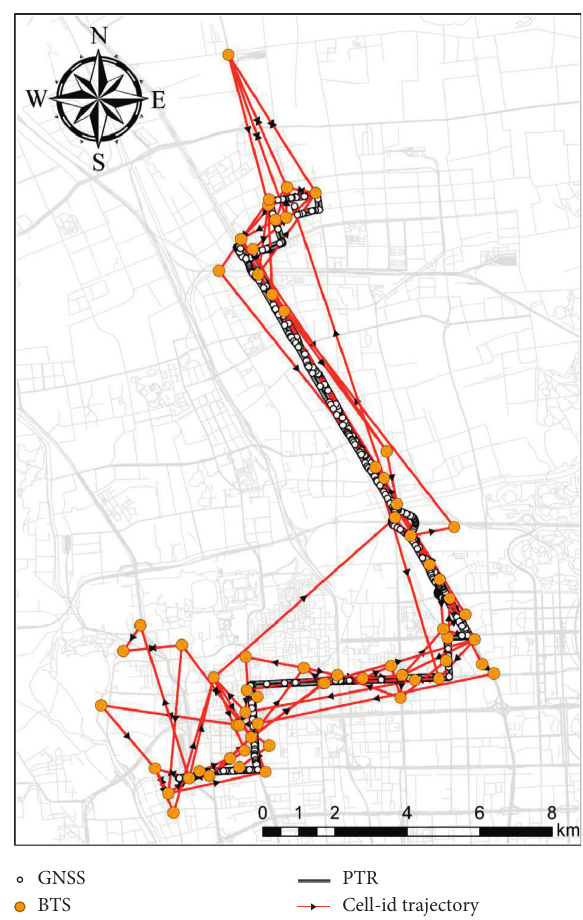
Figure 6: Ground truth data (GNSS vs